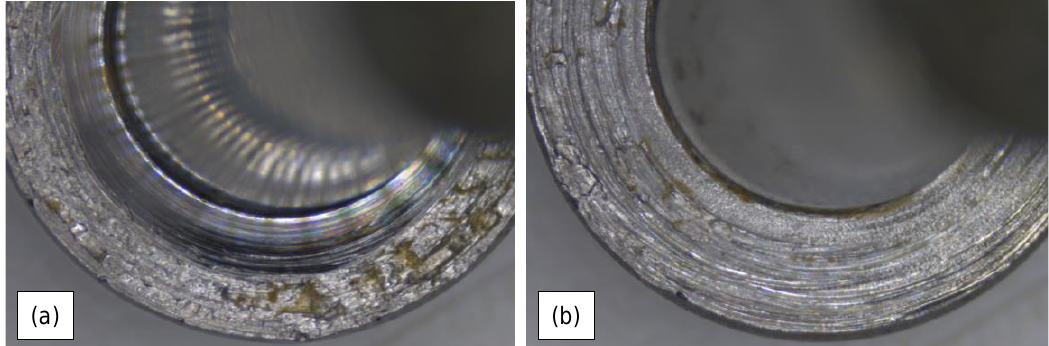
Figure 7. Microscope images of the surfaces at the underhead after tribological tests in dry conditions with reference to ( a ) an unpeened and ( b ) a Z100 10-12N peened screw.